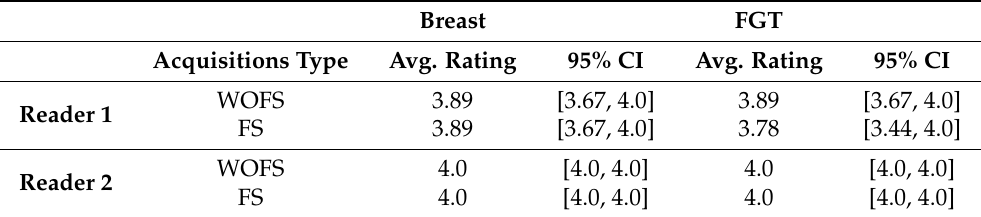
Table 4. Internal test set results (n = 9 patients, 18 acquisitions (9 WOFS, 9 FS)). Reader study average